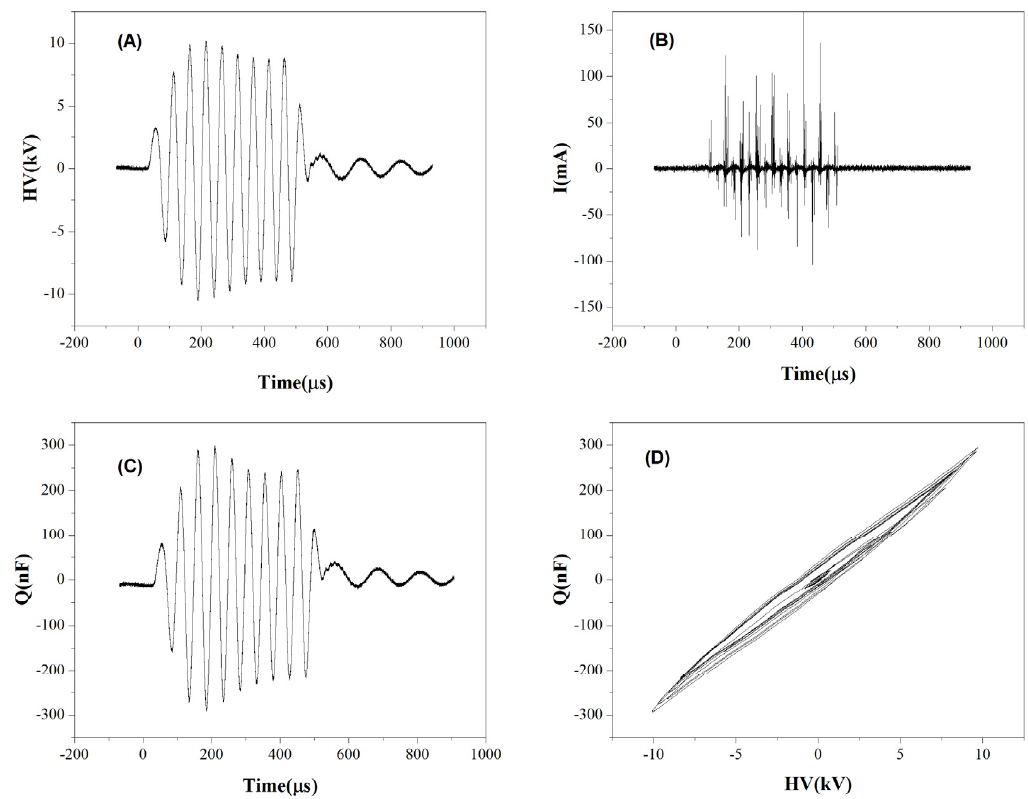
Figure 2. Typical waveform for 1 burst applied to the discharge reactor: ( A ) voltage; ( B ) current; ( C ) charge; ( D ) Lissajous figure for estimating the burst energy deposited in the plasma phase.